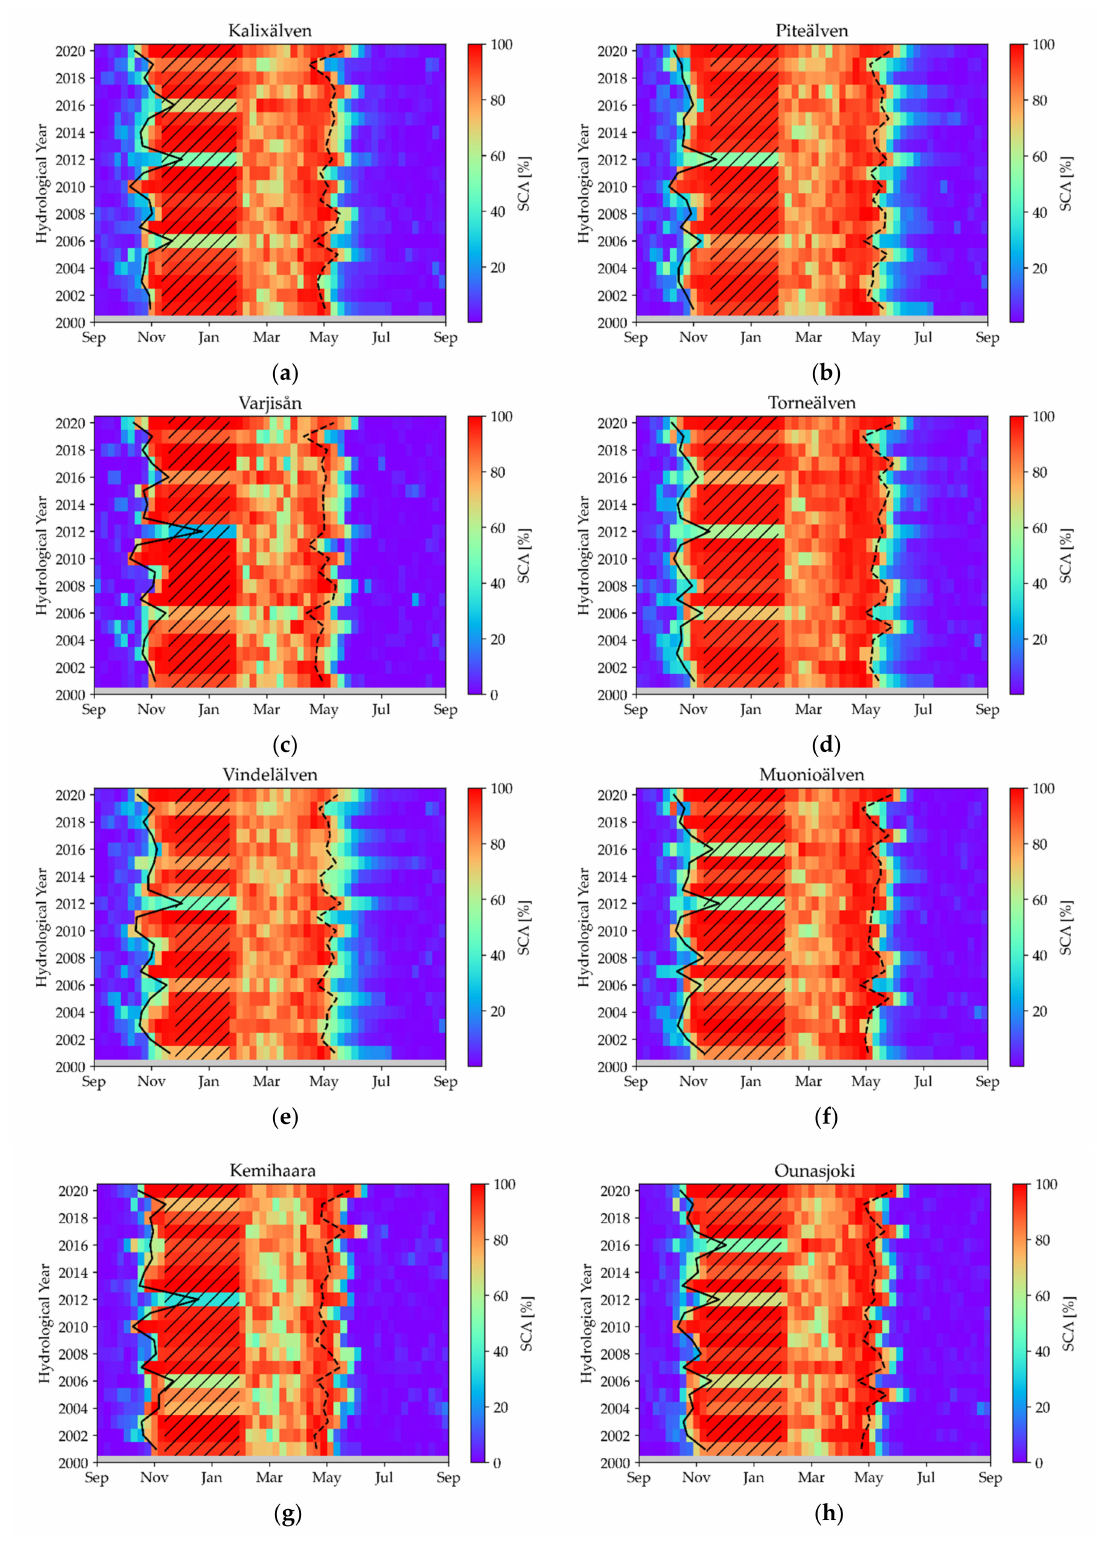
Figure 6. Weekly mean of snow coverage for the hydrologic years 2001 to 2020 for ( a ) Kalixälven, ( b ) Piteälven, ( c ) Varjisån, ( d ) Torneälven, ( e ) Vindelälven, ( f ) Muonioälven, ( g ) Kemihaara and ( h ) Ounasjoki. The hatched area shows the polar night (depending on the catchment area between weeks 10 and 22), the solid line shows the calculated SCD ES , the dashed line the time of the SCD LS